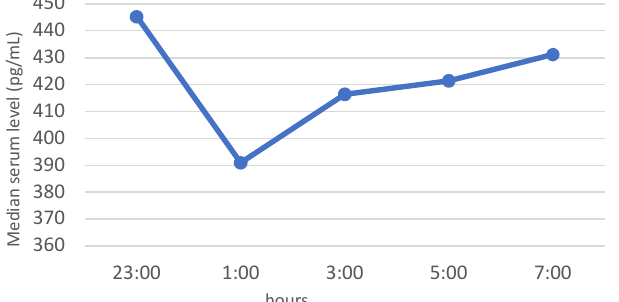
Figure 1. Night profile of ghrelin in the study group.